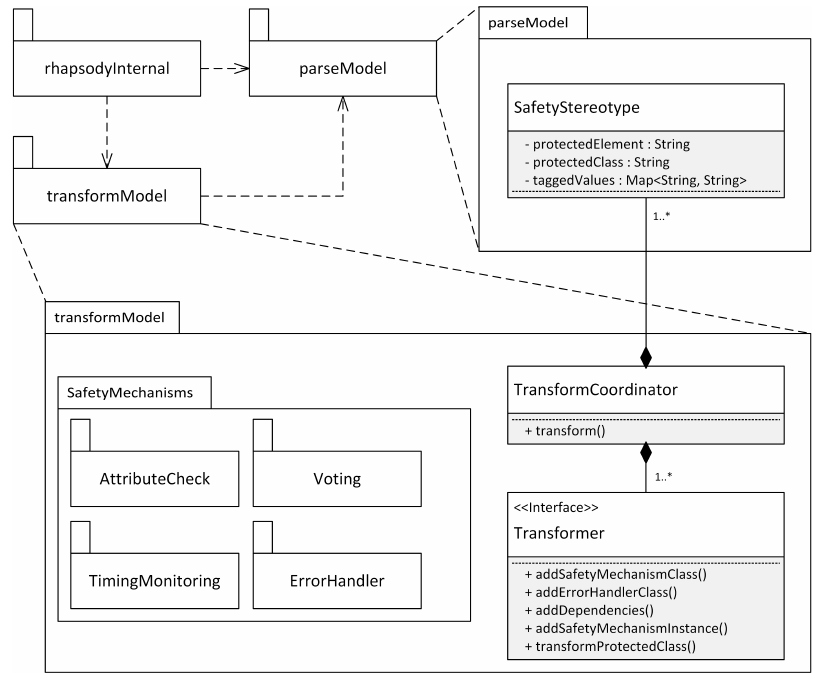
Figure 12. Integration of software-implemented safety mechanisms in an existing software architec- ture (UML 2.5